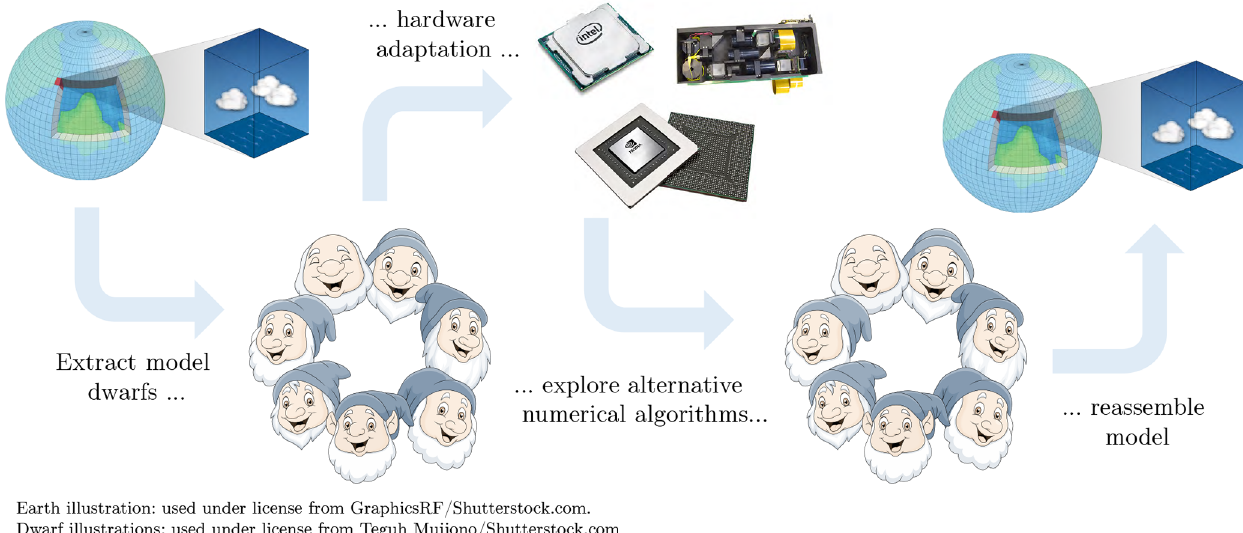
Figure 1. Illustration of the main idea behind the ESCAPE project. The entire model is broken down into smaller building blocks called dwarfs. These are adapted to different hardware architectures. Based on the feedback from hardware vendors and high-performance comput- ing centres, alternative numerical algorithms are explored. These improvements are eventually built into the operational